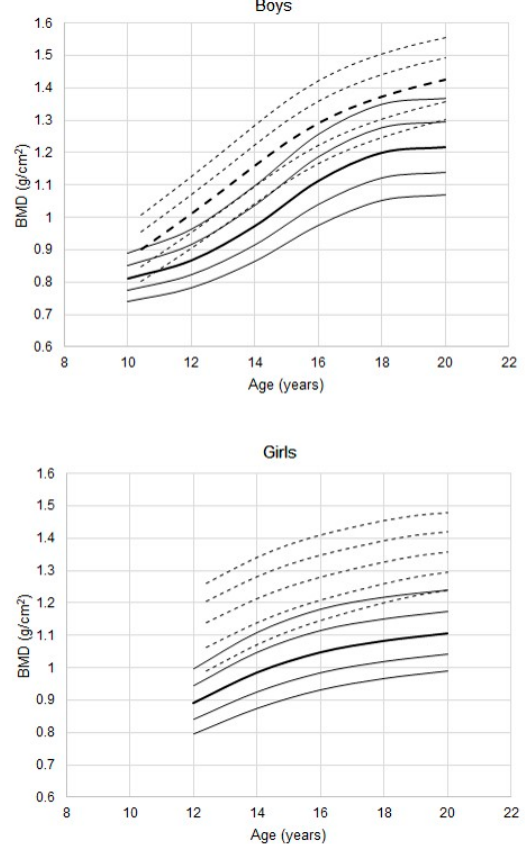
Figure 1. Total bone mineral density (BMD) in youth male and female athletes 11 to 20 years of age; percentiles (- - -) for athletes estimated with the LMS method, are plotted relative to the DEXA (dual energy X-ray absorptiometry) reference (—) percentiles (10th, 25th, 50th, 75th, 90th; the 50th percentiles are in bold).